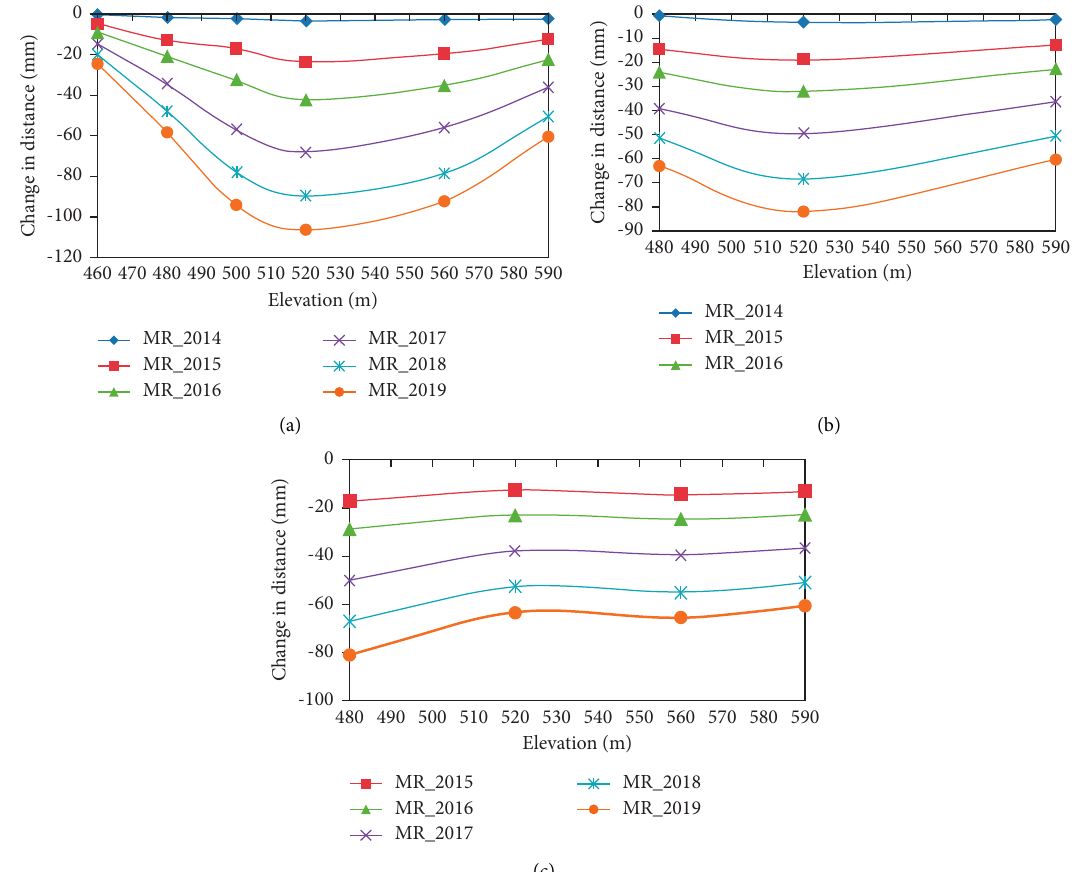
Figure 10: Relationship between change in distance from 2014 to 2019 and elevations at (a) the left-hand side, (b) centre, and (c) right-hand side of the